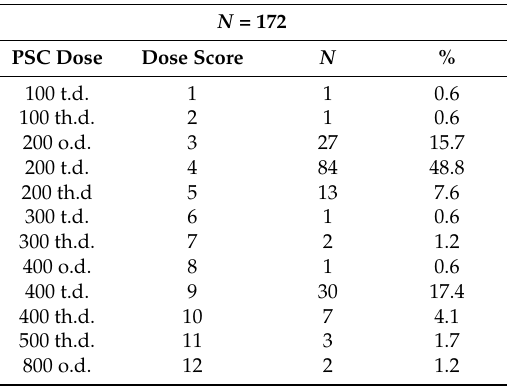
Table 2. Number and percentage of patients for each dose regimens.